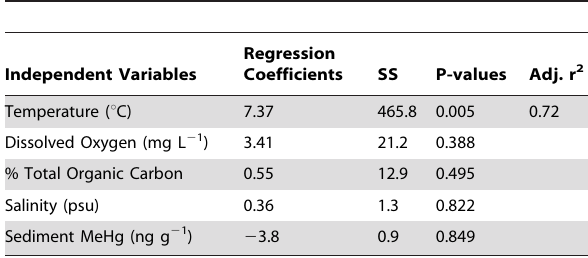
Table 1. Multiple regression analysis for pool samples; temperature was the only significant predictor in the model.